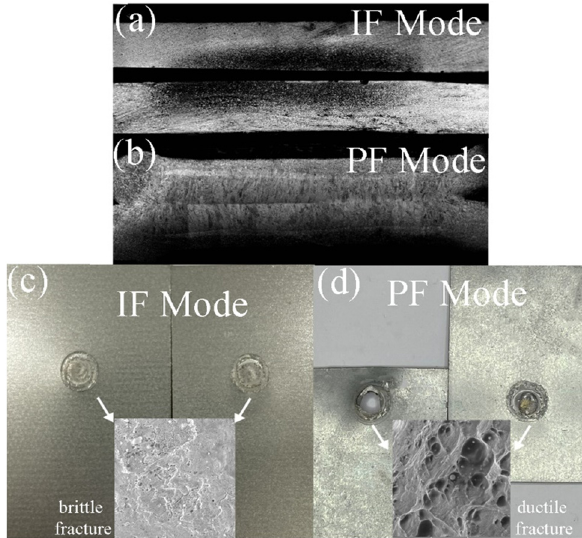
Figure 15: Fracture mode and morphology of spot welded joint: ( a ) Morphology of interface fracture, ( b ) morphology of pull - out frac - ture, ( c ) fracture appearance of Interface fracture, and ( d ) fracture appearance of Interface fracture pull - out fracture.